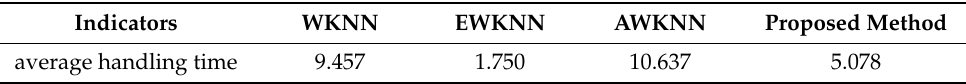
Table 6. Statistics of average handling time of four methods